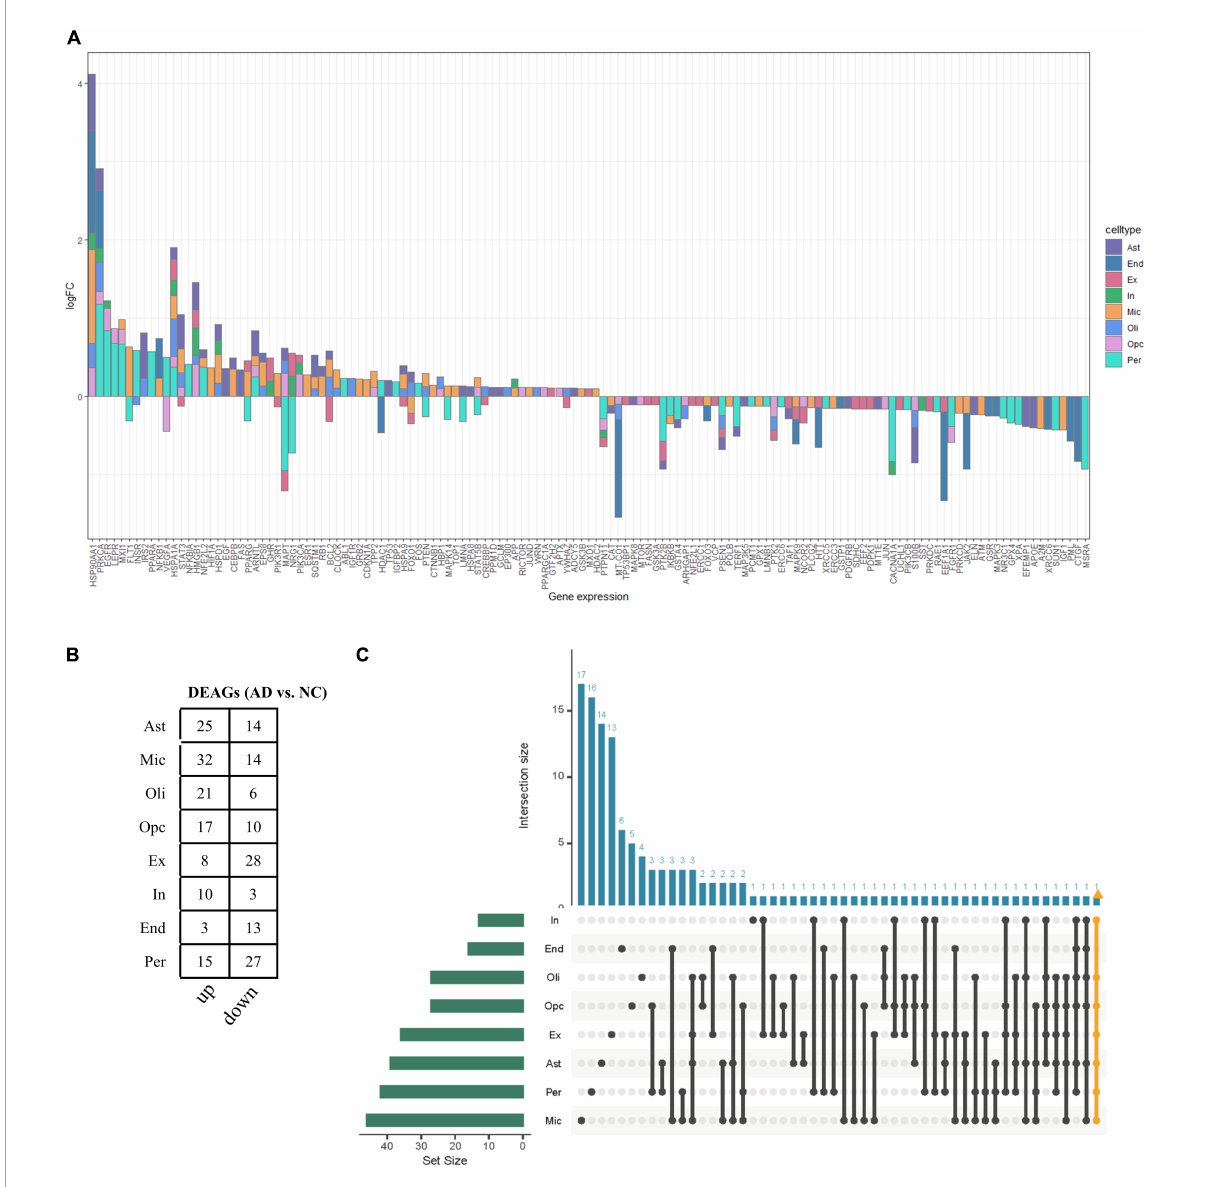
FIGURE3 Aging-associated transcriptomic changes in NVU cells. (A) Consensus DEAGs upregulated (positive log2 FC) or suppressed (negative log2 FC) in NVU cells ( p < 0.05, | log2 FC| > 0.1). (B) Numbers of DEAGs between AD and NC samples within each cell type. Down: downregulated; up: upregulated. (C) UpSet plot depicting the number of overlap DEAGs across all eight cell types. Also shown are the numbers of DEAGs specific to each cell type. AD, Alzheimer’s disease; Ast, astrocyte; DEAGs, differentially expressed aging-related genes; End, endothelial cell; Ex, excitatory neuron; FC, fold change; In, inhibitory neuron; Mic, microglia; NC, normal control; Oli, oligodendrocyte; Opc, oligodendrocyte progenitor cell; Per,